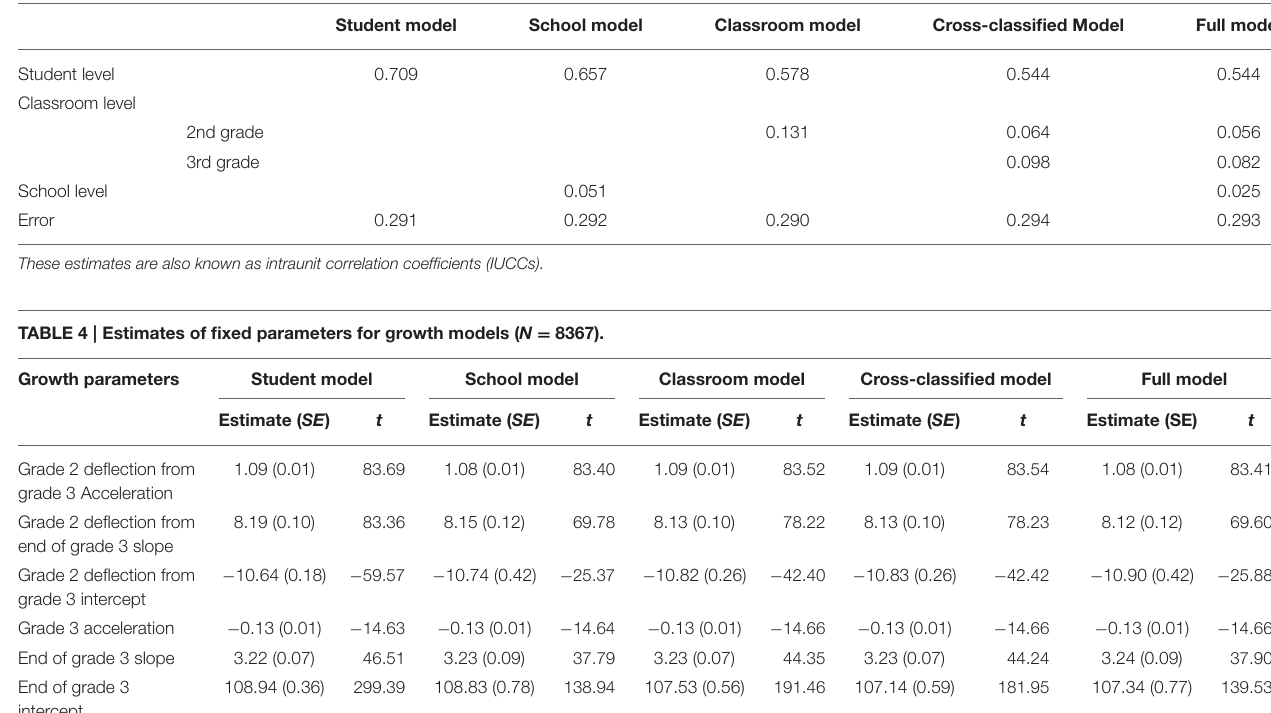
TABLE 3 | Proportion of variance explained at each level for unconditional means models ( N = 8367).